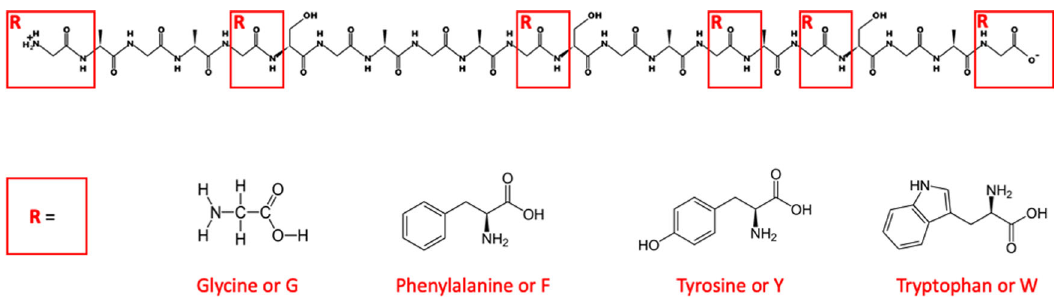
Fig. 1 Schematics for chemical structure of peptide model and glycine to aromatic amino acid substitution. General chemical structure of peptides with